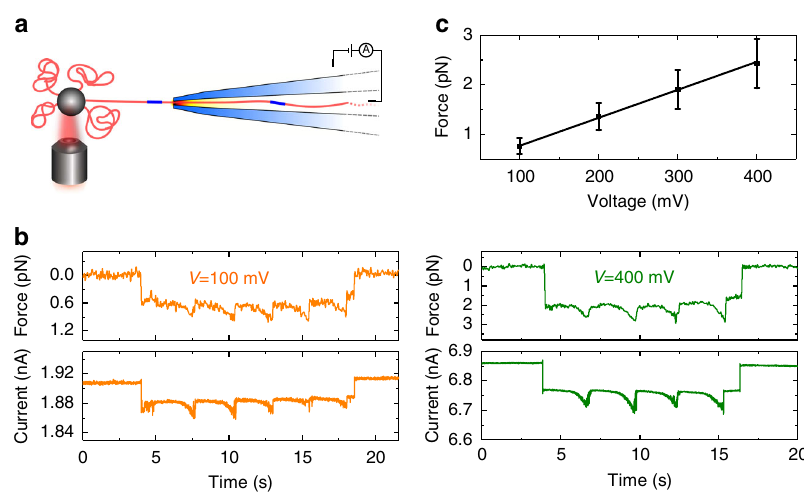
Fig. 5 Determination of force on DNA using optical tweezers. a Schematic showing DNA stalled in a tug of war with the force from the optical trap equalling the combined force due to electrophoresis on the DNA and drag from electroosmosis. b Example traces showing simultaneous force and current recordings at 100 and 400 mV. After the DNA enters the nanopore, the colloid was immediately retracted at a speed of v = 115 nm/s. The number of peaks due to dumbbell sections is determined by how close the colloid is initially to the nanopore when the DNA is stalled. The force traces were fi ltered at 10 Hz and the current traces at 100 Hz for display. The force decreases slightly towards the end of the trace since the DNA no longer occupies the high electric fi eld zone which extends a few hundred nanometres from the pore entrance 59 . c Force vs. voltage relationship. Data points show the mean value of a Gaussian fi t to an all points histogram with the error bar showing the standard deviation of the fi t. The gradient of the line is 5.6 fN/mV Table 1 Values of experimental parameters Experimental parameter Value Unit Applied voltage ( V )